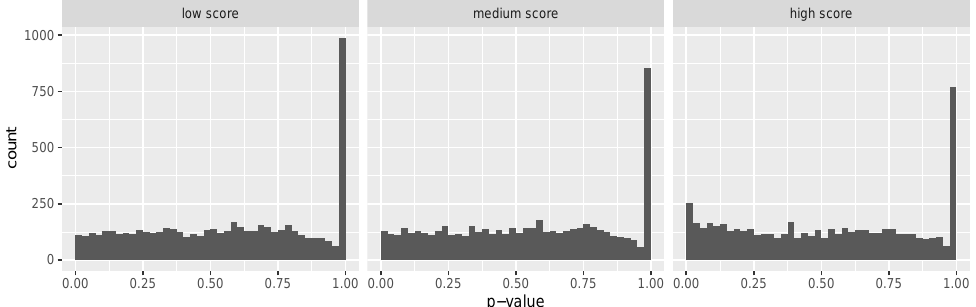
Figure 4. Histograms of SCHEMA reported [16] p -values after splitting the hypotheses into three groups by the prediction score. A successive increase of the number of hypotheses with p -values near zero is observed for increasing scores, indicating that the proportion of non-null effects varies across different groups.